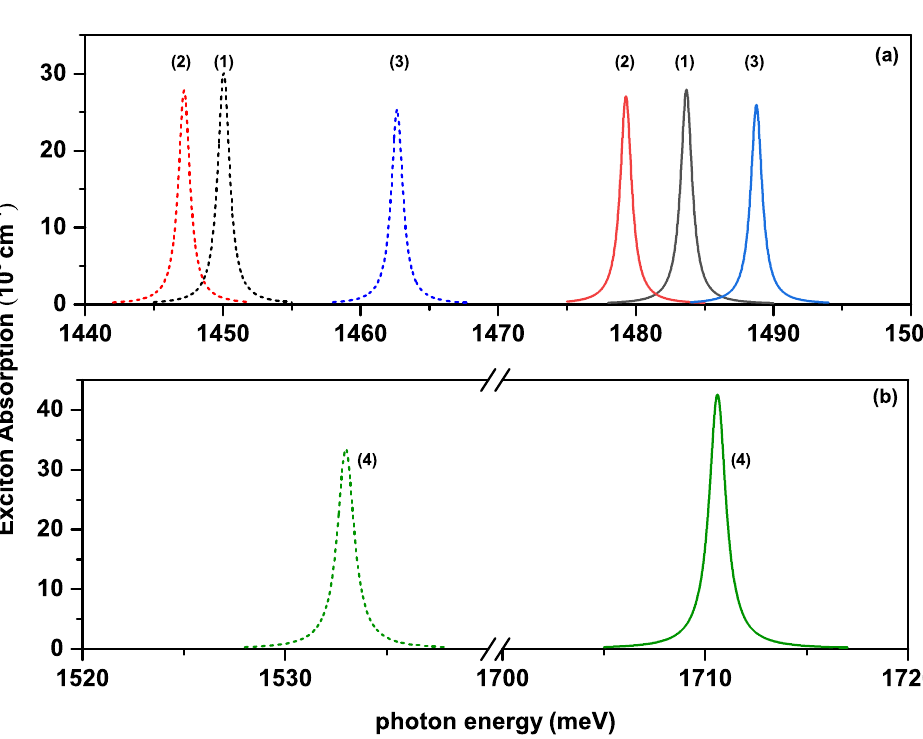
Figure 5. The exciton absorption coefficients for interband transitions as a function of the incident photon energy for confinement potential V 2 ( z e ( h ) ) , with ν 2 = − 2. Several combinations of the fields ( F , B , α ) (with F in kV/cm, B in Tesla, and α 0 0 in nm) were considered and are indicated by labels 1, 2, 3, and 4: in ( a ) the results are for (0,0,0) (1), (25,0,0) (2), and (0,10,0) (3). In ( b ) the results are for (0,0,10) (4). Solid lines are for L ef f = 10nm, whereas dashed lines are for L ef f =